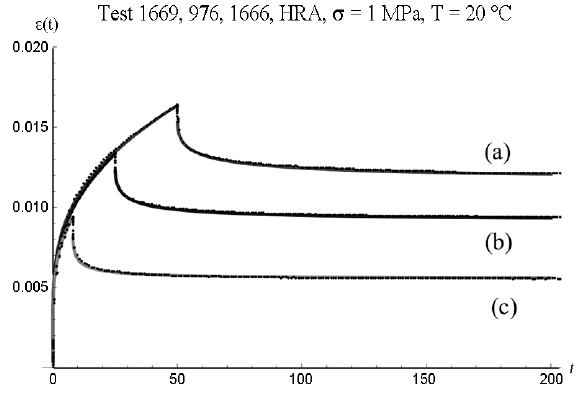
Fig. 8. Experimental curves matched with theoretical laws for creep recovery tests carried out at different loading time: t * = 50 s (a); t * = 25 s (b); t * = 8 s Table 4. Best fitting parameters (coefficients of Eqn 17) of 1669, 976 and 1666 creep recovery tests